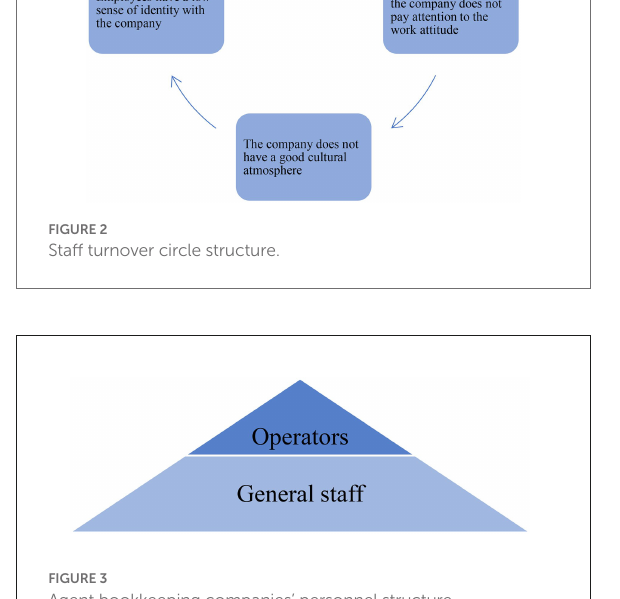
FIGURE 3 Agent bookkeeping companies’ personnel structure.